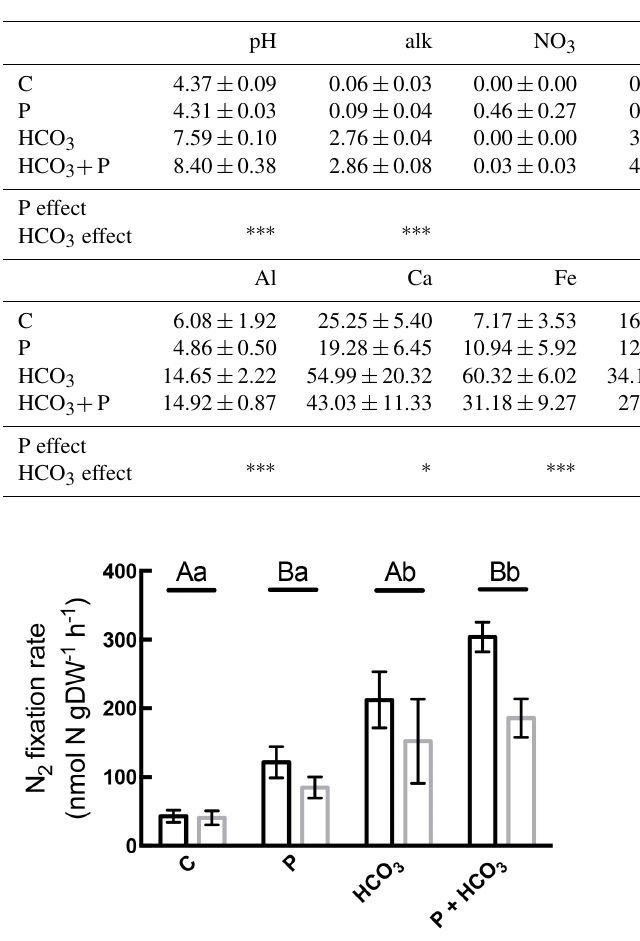
Table 2. Surface water characteristics for the different treatments: control (C), addition of P (P) or HCO − Displayed are means ± SE of the mean (N = 4). The unit for alkalinity (alk) is meqL − 1 ; for all elements concentrations are expressed in µmolL − 1 . In the effect row, significant differences of P or HCO 3 treatment are indicated by asterisks, where ∗ represents P ≤ 0.05, ∗∗ represents P ≤ 0.01 and ∗∗∗ represents P ≤ 0.001.